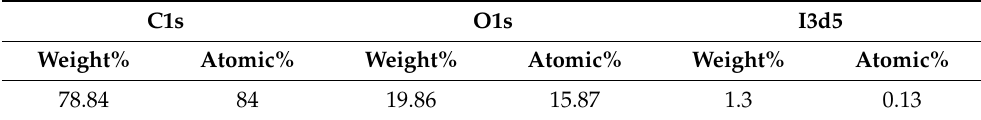
Table 2. Chemical composition for prepared iodine-doped graphene.